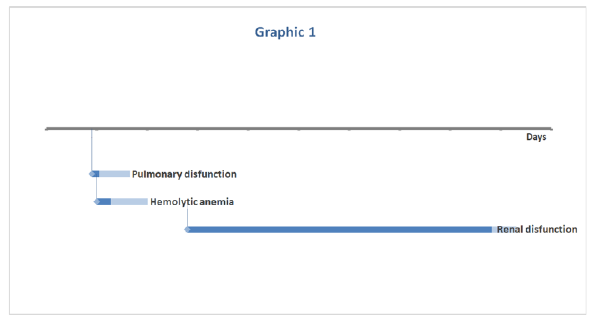
Graphic 1. Represents the duration of each clinical presentation in